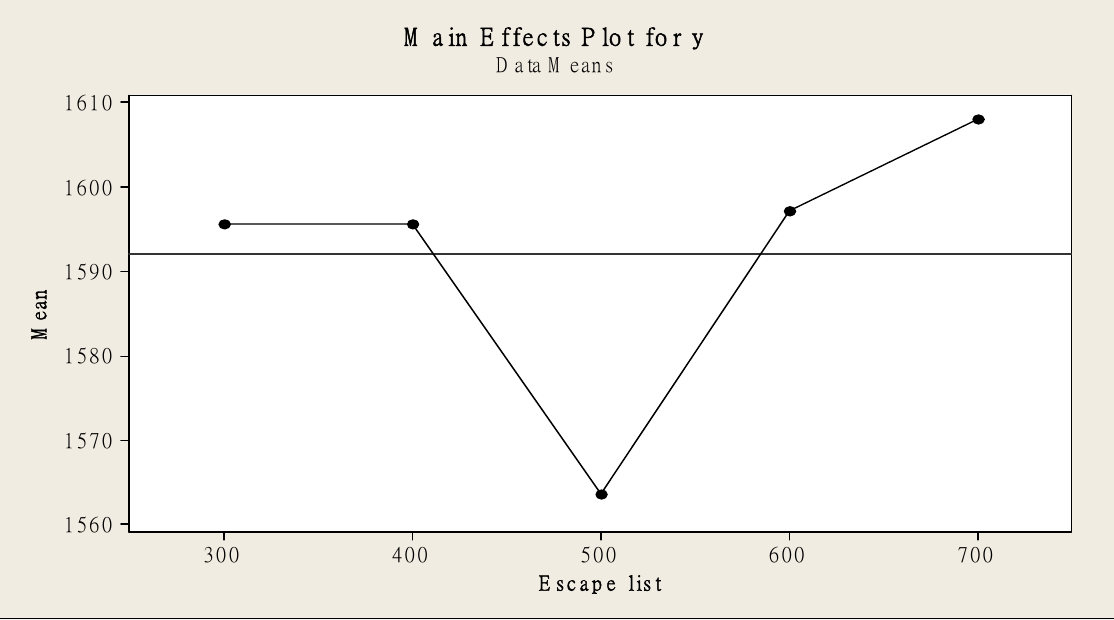
Figure 11. The mean plot of the escape list for a one ‐ factor factorial design. It is found that the sAIS method can generate a better ‐ quality solution when the pop ‐ ulation size and escape list factors are assigned to 300 and 500. According to the literature review, the maximum iteration was set at 100,000 trials as the termination criterion in our experiments. These settings were used in the following experiment for the sAIS algorithm. On the other hand, the population size of genes in the GA method was set at 50; the mu ‐ tation rate is 0.06; and the crossover rate is 0.15. The maximum iteration number was 5000 trials with 30 replications for each instance. 5.2. Experiment Results